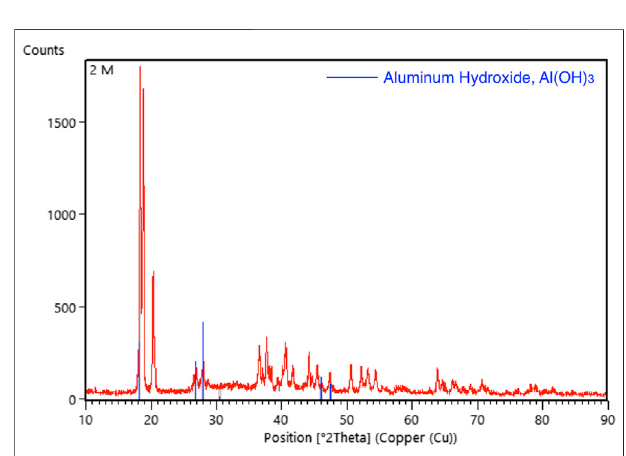
FIGURE 11 | Graphic comparing the XRD pattern (red line) of aluminum foil after tested with 2 M of KOH solution with the standard aluminum hydroxide XRD pattern (blue